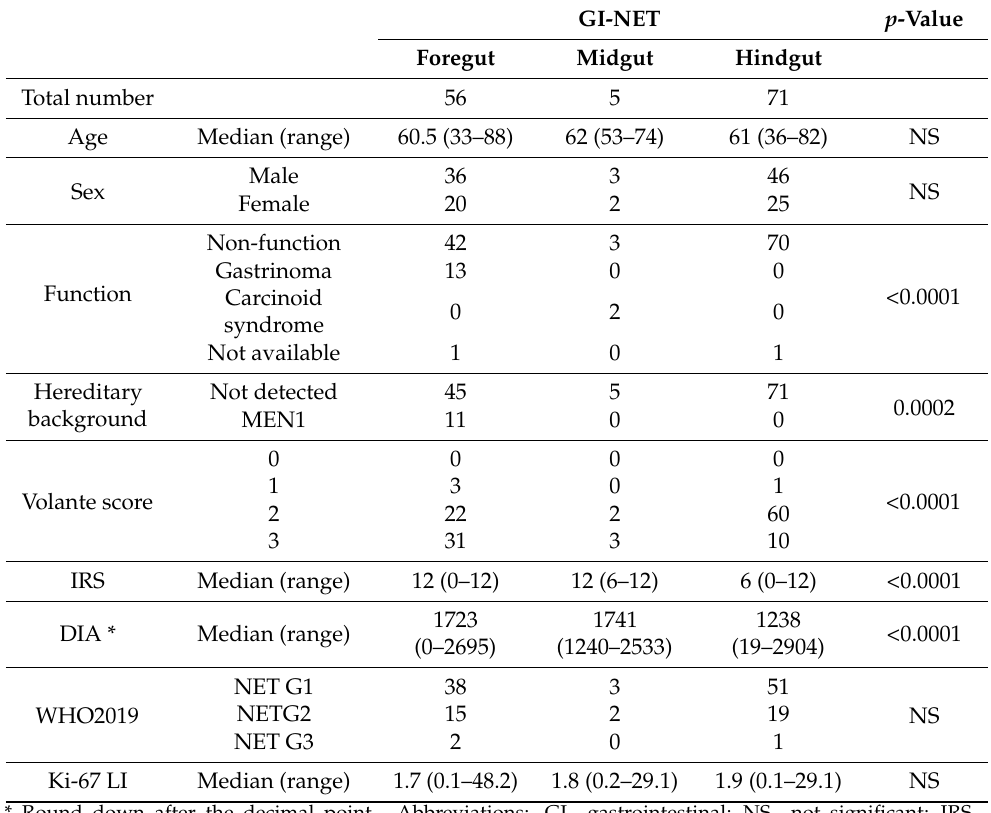
Table 2. Summary of the clinicopathological characteristics of Group 2 patients.